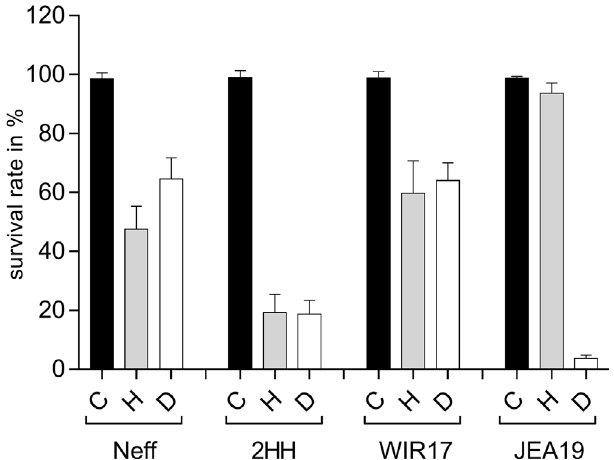
Figure 3. Survival rates of investigated Acanthamoeba strains after challenge with elevated concentrations of H 2 O 2 and diamide for two hours. C: untreated control; H: treated with 1.5 mM H 2 O 2 ; D: treated with 5 mM diamide. Values were obtained from three biological replicates in triplicate. Error bars show the standard deviation of the mean